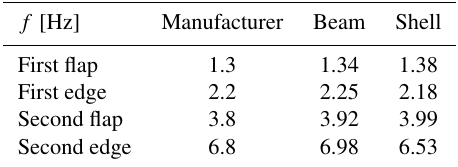
Table 5. Comparison of the first four eigenfrequencies of the blade. f [Hz]